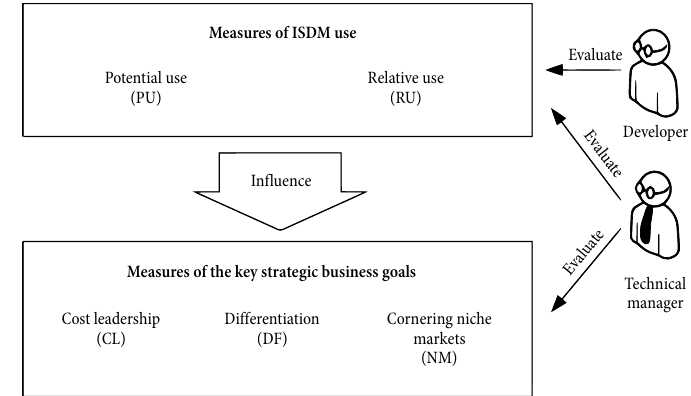
Fig. 1. The model depicting the influence of the use of ISDM on strategic business goals